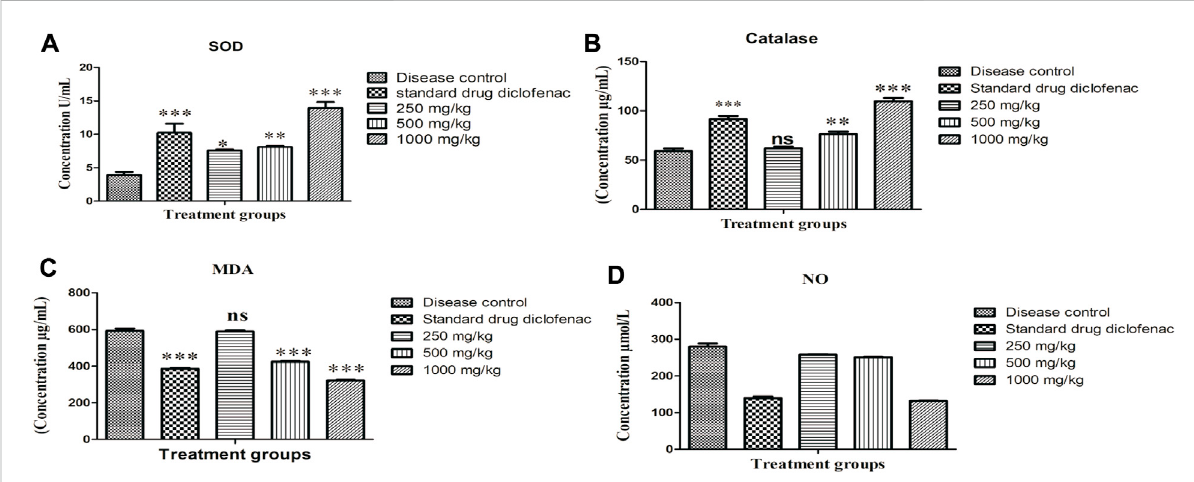
FIGURE 3 Effect of Alternanthera bettzickiana ethanolic extract on oxidative stress biomarkers (A) SOD, superoxide dismutase, (B) catalase, (C) MDA, malondialdehyde,and (D) NO,nitricoxideinformaldehydeinducedarthritis.Resultsarepresentedasmean±SEM( n =5)andanalyzedwithone-way ANOVAfollowedbyaBonferroniposttest.*** p < 0.001;** p < 0.01;* p < 0.05;ns,nonsigni fi cantascomparedtodiseasecontrol.ABEE, Alternanthera bettzickiana ethanolic